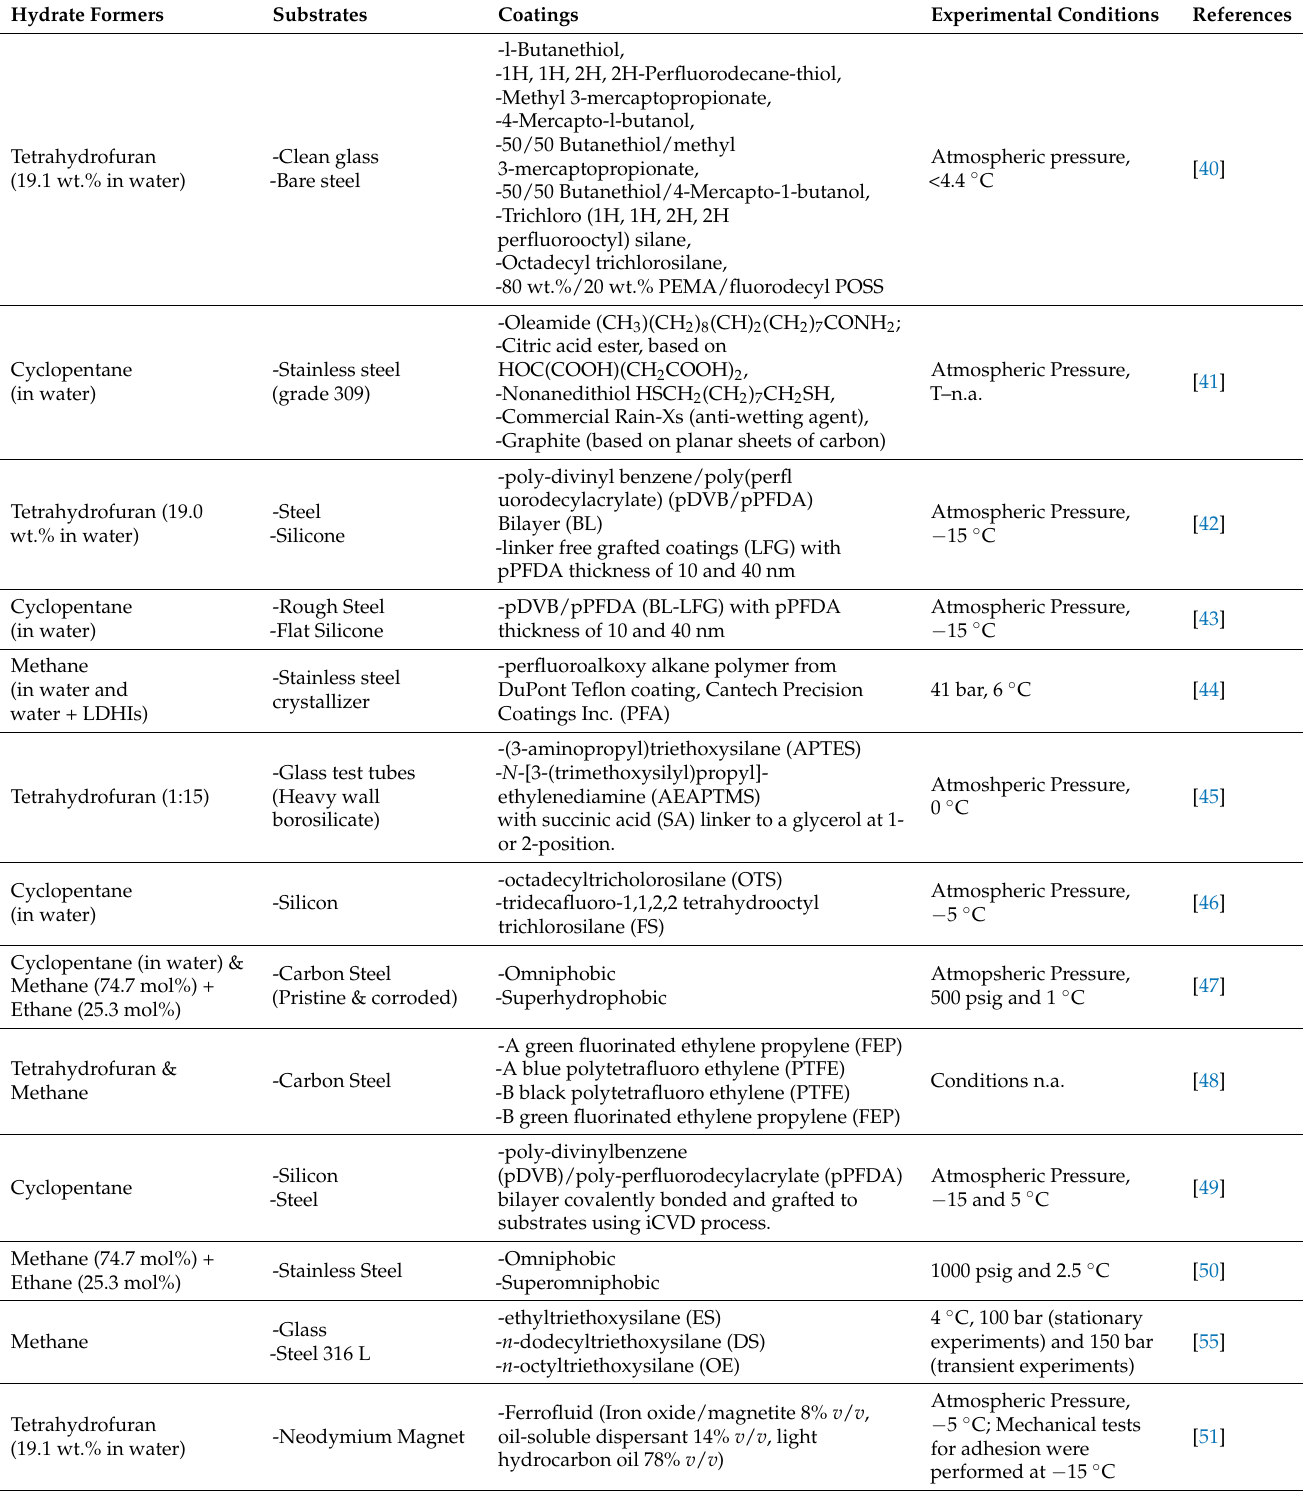
Table 1. List of surface coatings or treatments, substrates, hydrate-forming substances, and conditions at which the tests were carried out to ascertain reduction or promotion in hydrate adhesion along with the respective